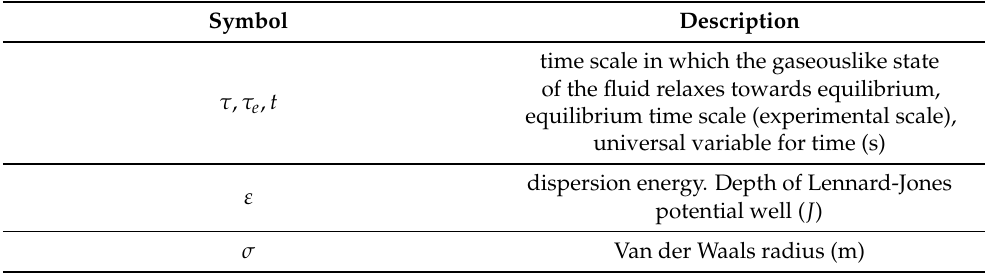
Table A1. Nomenclature used in this paper with SI